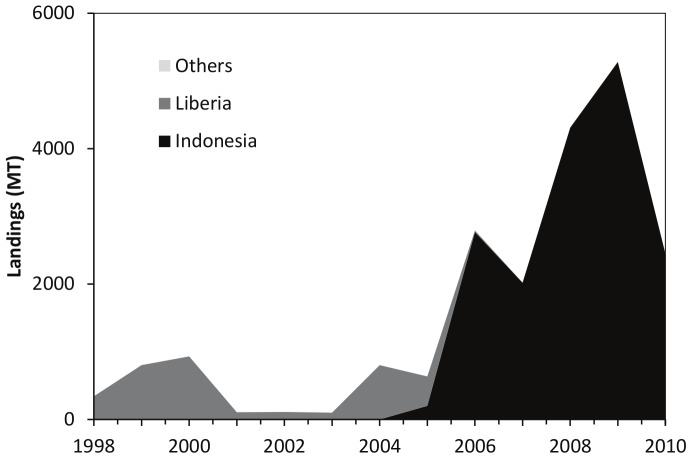
Landings trends.Globally reported Manta and Mobula landings were derived from the FAO Fisheries and Aquaculture FishStatJ dataset [36] by country (in metric tons). The relevant FAO species categories (“Giant manta” and “manta/devil rays, nei”) were pooled. An undifferentiated category of ‘rays, stingrays, manta nei’, was excluded from our dataset, because the proportion of mobulids in this category could not be estimated. No mobulid landings were reported prior to 1998. Note that other countries’ (Spain and Ecuador) reported landings were relatively small (<10t yr−1) and hence not visible at this scale.